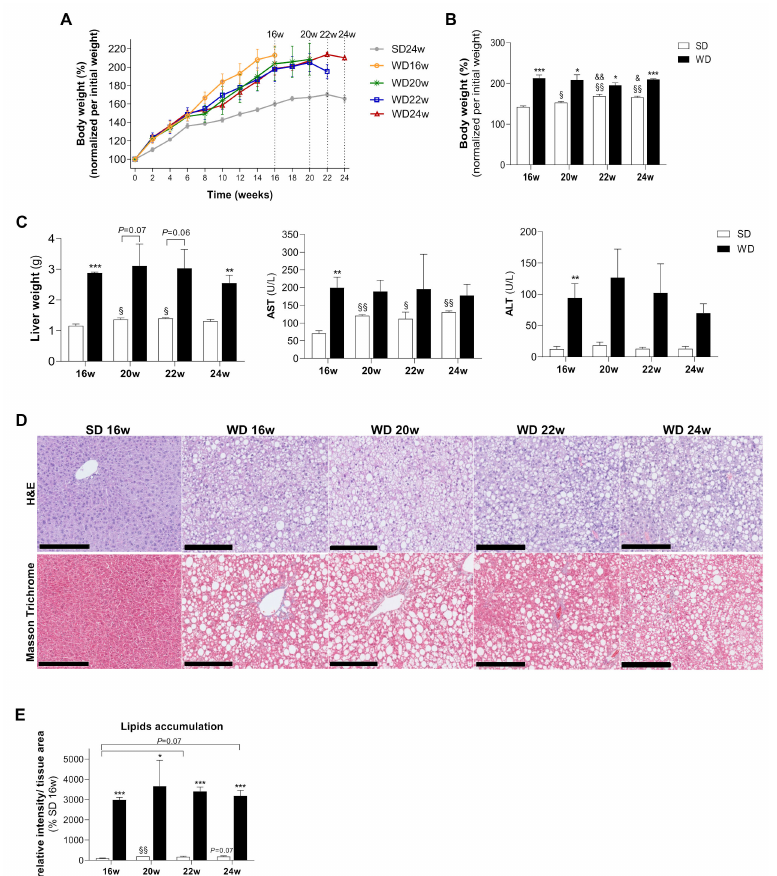
Figure 1. Western diet (WD) causes body weight gain concomitant with hepatic steatosis and damage along 24 weeks of feeding when compared with standard chow diet (SD). ( A ) Body weight gain profile along 16, 20, 22, and 24 weeks of WD feeding. ( B ) Body weight at the correspondent euthanasia time. ( C ) Wet liver weight at the euthanasia time and aspartate aminotransferase (AST) and alanine aminotransferase (ALT) plasmatic activity levels. ( D ) Representative images of paraffin-embedded liver sections with hematoxylin and eosin (H&E) and Masson Trichrome stains. Scale bar, 250 µ m; 10 × magnification. ( E ) Neutral lipids levels were obtained from the quantification of H&E staining of three independent images per animal and condition, being data expressed in % of SD16w group. Number of replicates = 3. All data are expressed as the mean ± SEM. (*) vs. SD, (§) vs. 16 w, (&) vs. 20 w ( p < 0.05); (**) vs. SD, (§§) vs. 16 w, (&&) vs. 20 w. ( p < 0.01); (***) vs. SD ( p < 0.001); p values were determined using two-way